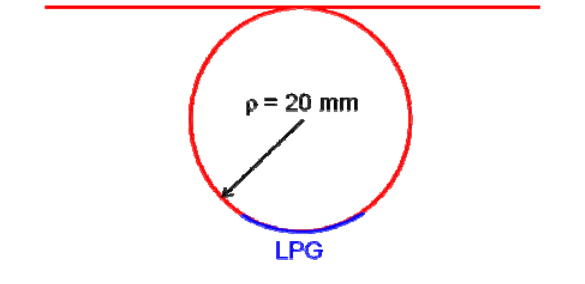
Figure 10. Discrimination of water from saline water with a 20-mm-long LPG having a bend radius of 20